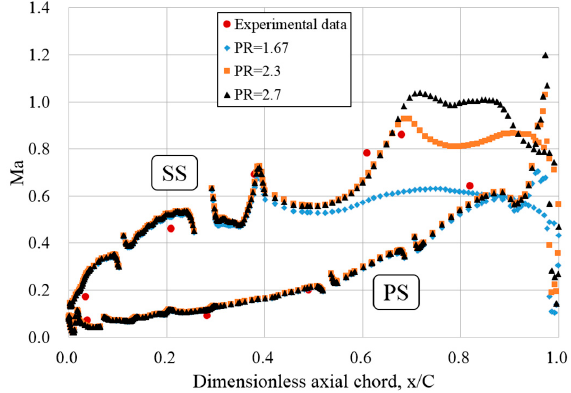
Figure 5. Mach number distributions along vane surface at midspan.